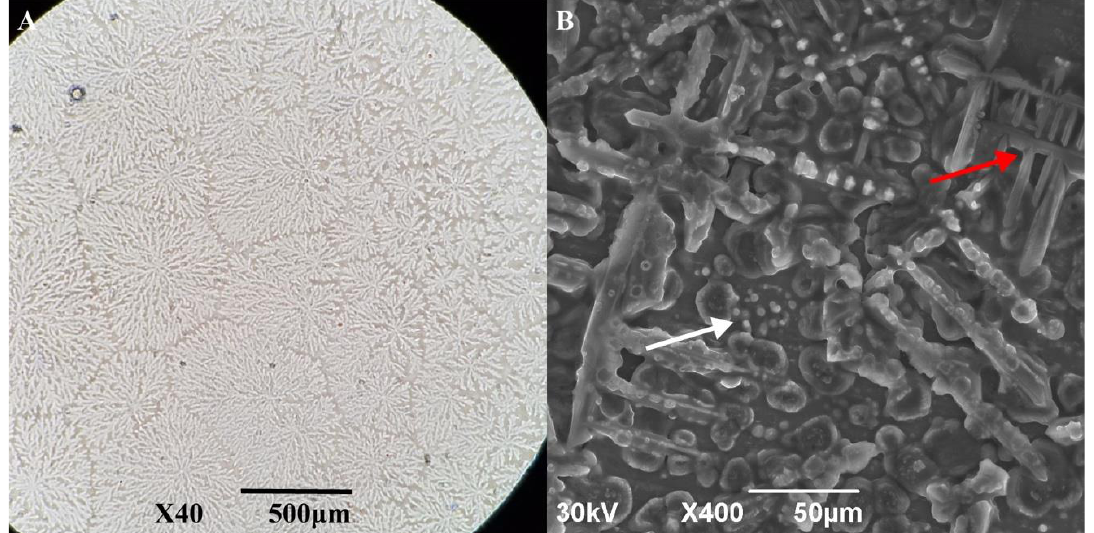
Figure 7. Af LEA1, dissolved in ultrapure water, crystallized readily when slowly desiccated at 80% RH. ( A ) Light microscopy shows that Af LEA1 dries into branching crystals. ( B ) Scanning electron microscopy (SEM) shows spherical structures (white arrow) are present in the desiccated sample in addition to the branching crystals (red arrow).